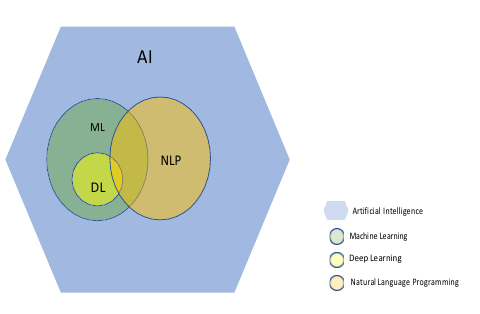
Fig. 2. The interrelation of Artificial Intelligence, Machine Learning, Deep Learning and Natural Language Programming